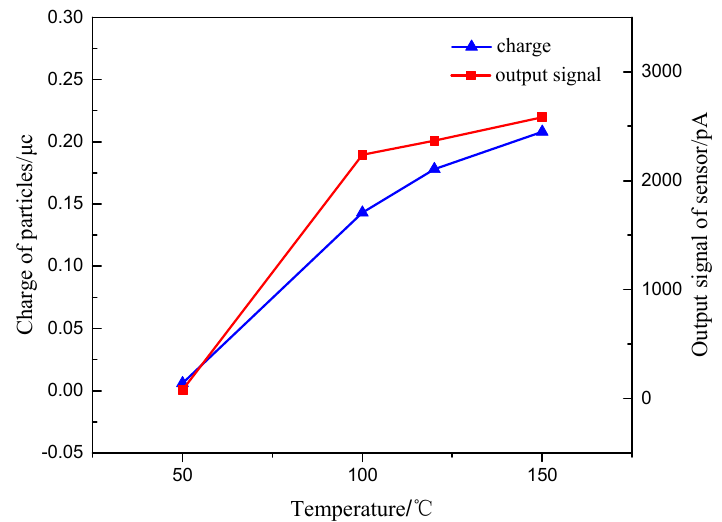
Figure 14. The relationship of charge of particles and output signal of sensor changing with different exhaust temperature.